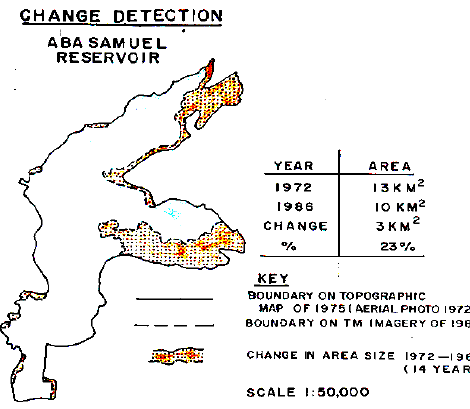
Figure 4. Results of comparison of area of the lake in years from 1972 to 1986